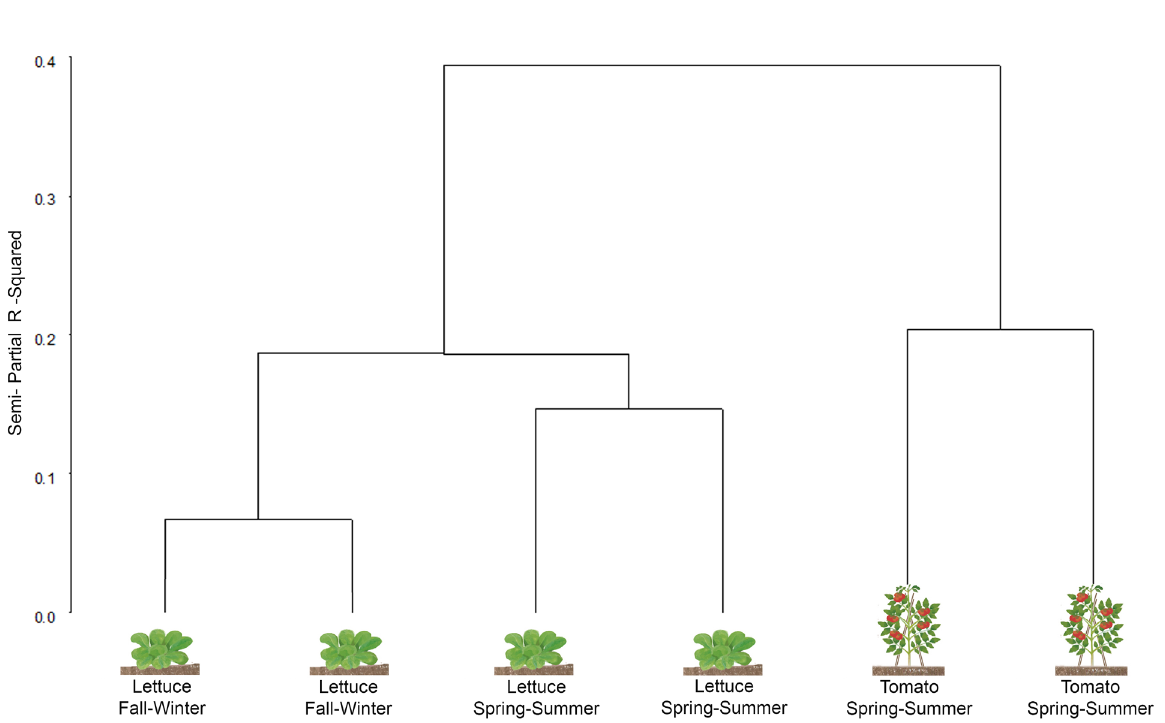
Figure 4. Cluster analysis for epigeic coleopteran assemblages conformed by the species of the dominant families Curculionidae, Carabidae Staphylinidae and Coccinellidae, inhabiting lettuce and tomato crops under different pest protection management (conventional use of insecticides –CM- and organic –OM- practices) in Northern Buenos Aires province, Argentina. Cropping seasons for lettuce: fall-winter and spring-summer. Years 2010-2013. Similarity index: Sørensen quantitative (CS) (Magurran